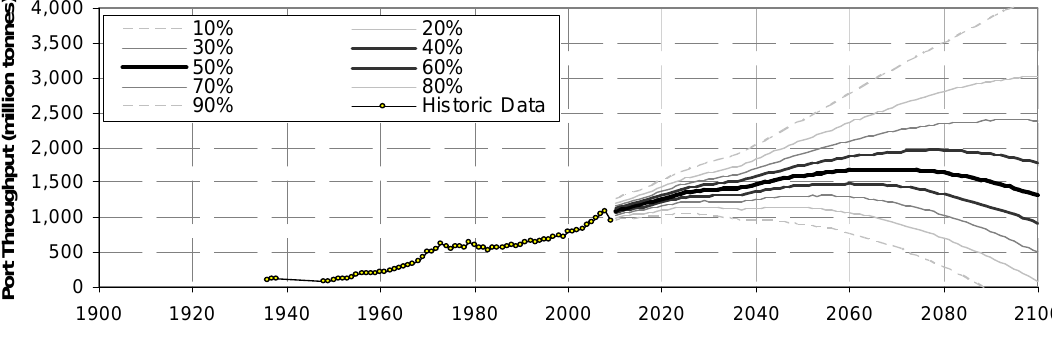
Figure 15. Single Forecast based on Differences Approach of Equation